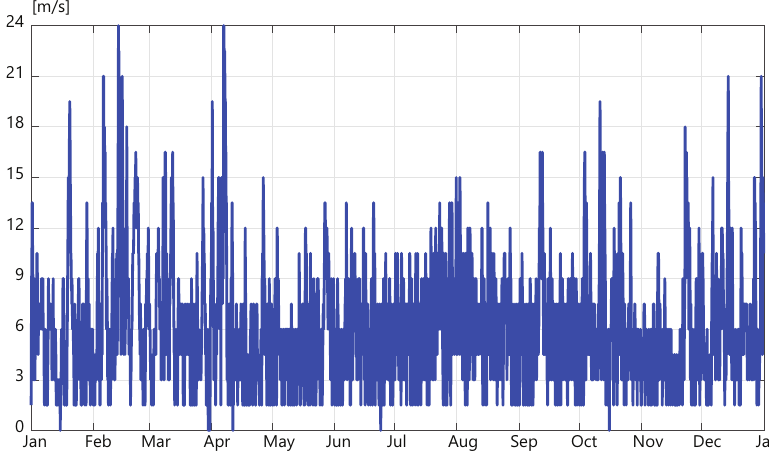
Figure 14. Wind speed in the Cala dell’Acqua area.